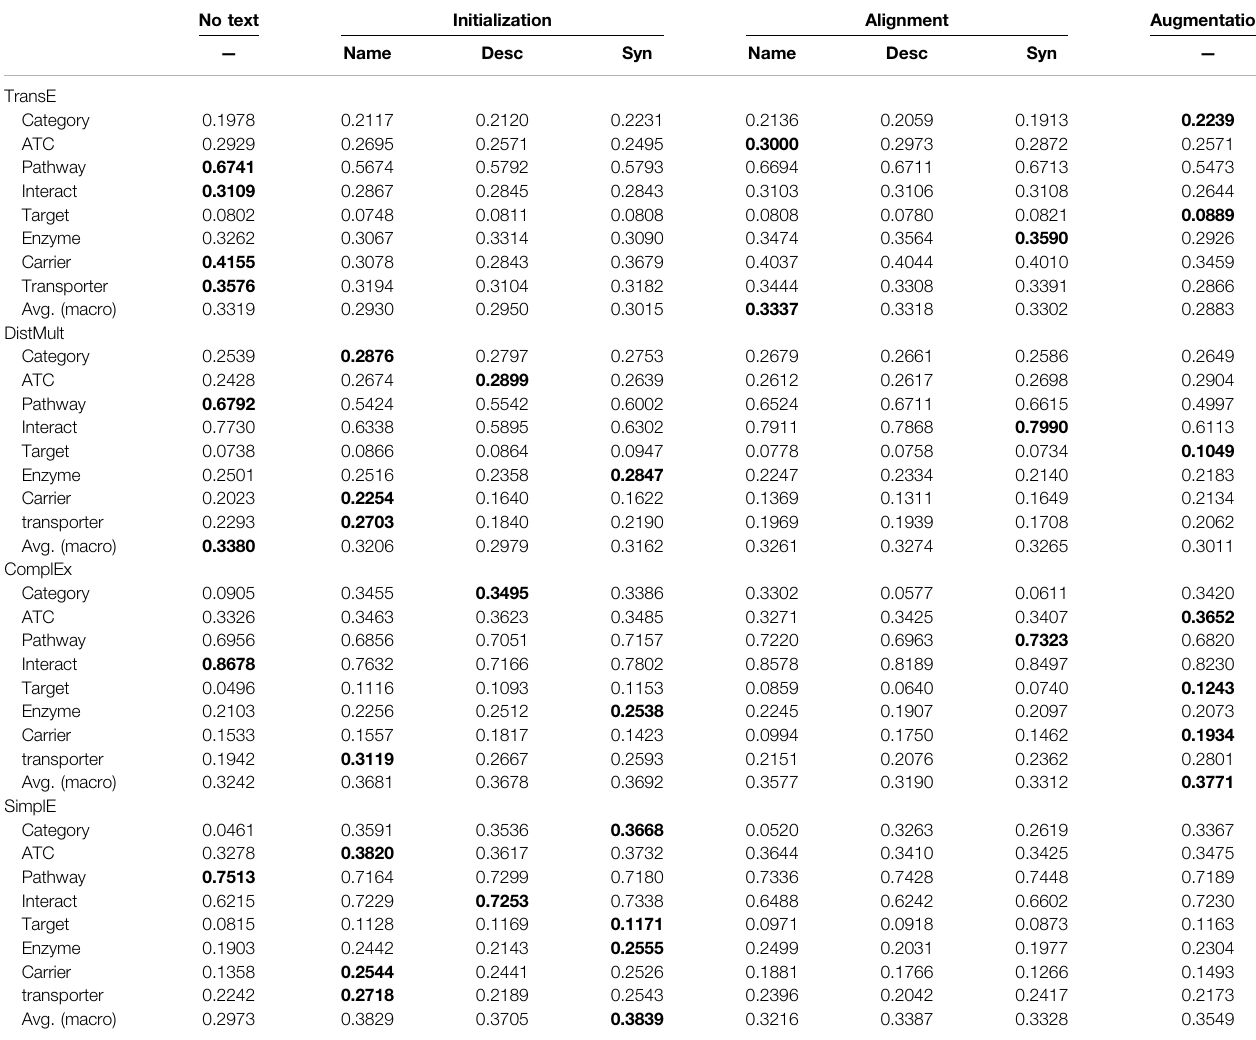
TABLE 4 | Comparison of MRR performance for each method.